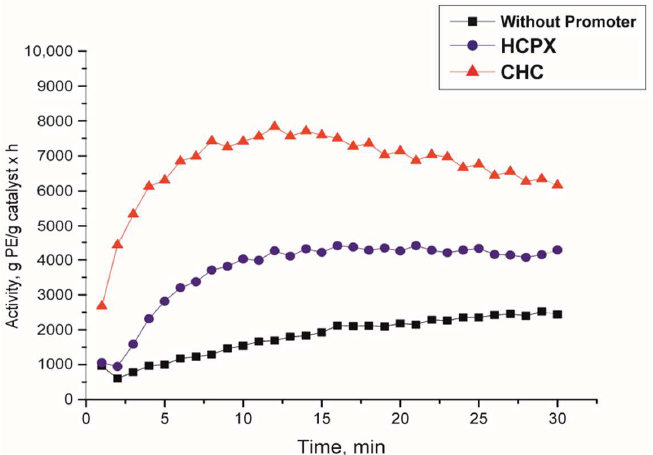
Figure 1. Effect of the presence of COC on the curve showing the dependence between activity of the catalytic system and duration of ethylene polymerization (the polymerization conditions are listed in Table 1): exp. 1—non-modified TMC, exp. 4—TMC modified with CHC, (C 6 H 11 Cl)/Ti = 1 (mol/mol), exp. 7—TMC modified with HCPX, (C 6 H 4 (CCl 3 ) 2 )/Ti = 1 (mol/mol).